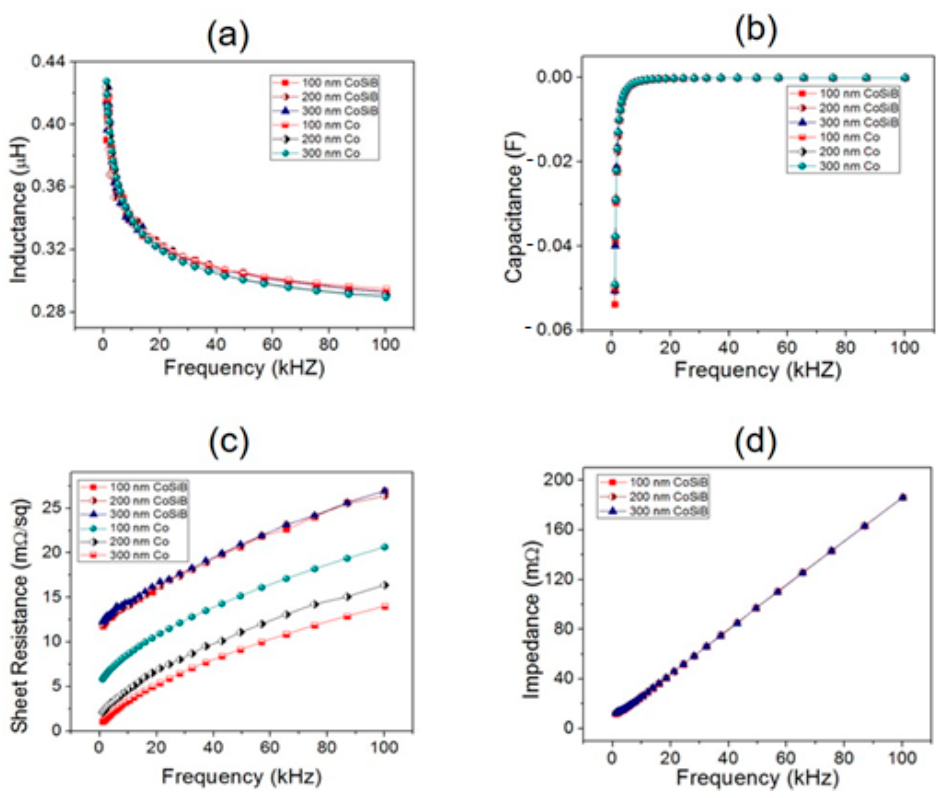
Figure 4. Four-probe electrical impedance component measurements in frequency ranges from 100 Hz to 100 kHz: ( a ) inductance, ( b ) capacitance, and ( c ) sheet resistance spectroscopies for the TFMG samples and Co thin film of different thicknesses. ( d ) Impedance spectroscopy of CoSiB TFMG of three different thickness.